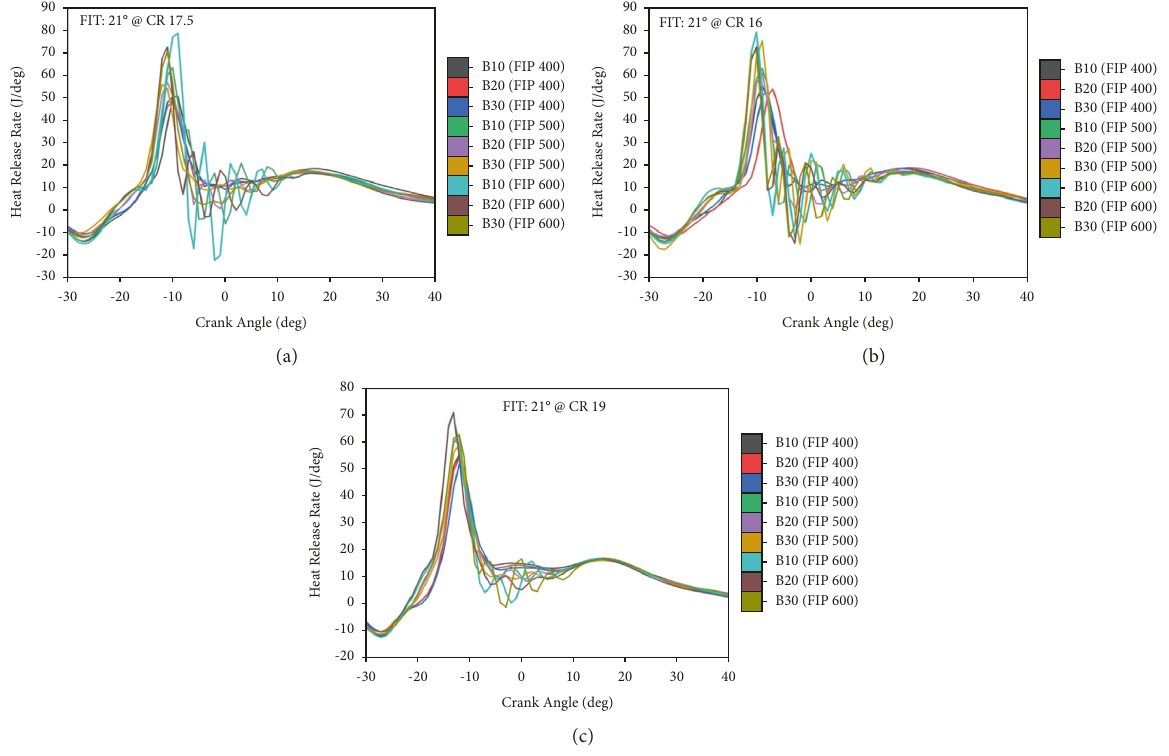
Figure 13: (a) Crank angle vs cylinder pressure at CR 16 and different FIPs. (b) Crank angle vs cylinder pressure at CR 17.5 and different FIPs. (c) Crank angle vs cylinder pressure at CR 19 and different